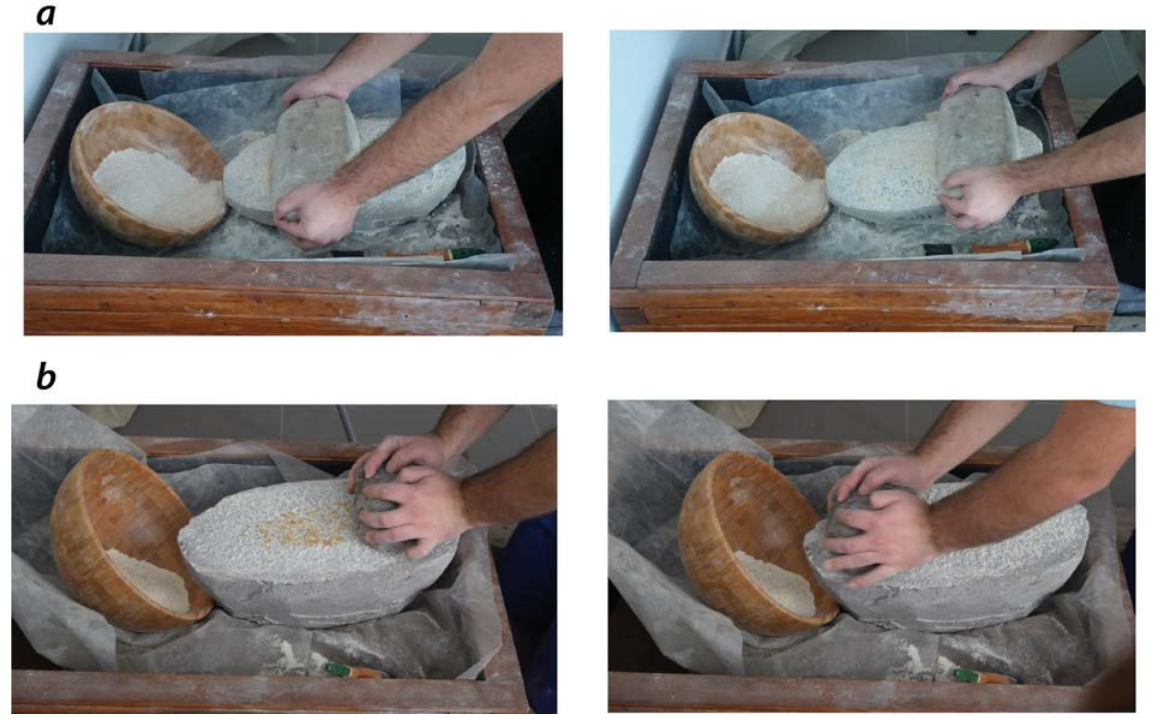
Figure 4. Experimental sequences. Experiment 1 grinding dehusked Einkorn with type 1 (a) and type 2